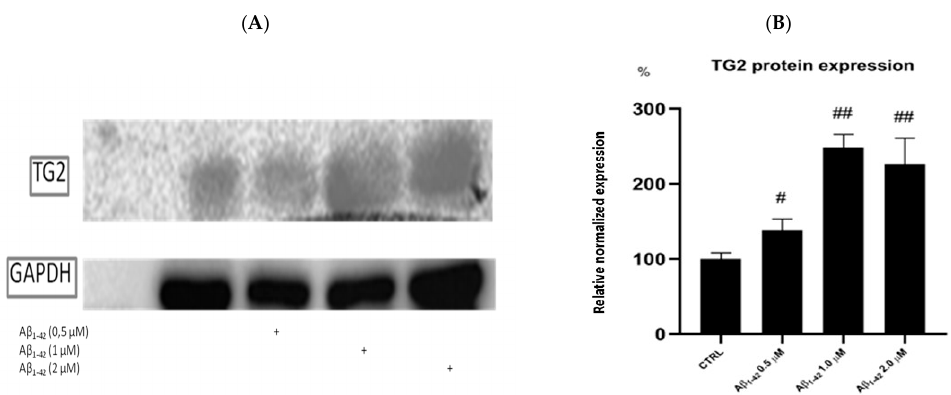
Figure 5. Panel ( A ): Western blot for TG2 expression in BV2 cells after treatment with different concentrations of A β 1-42 for 48 h. SDS-PAGE blotted with antibody against TG2. GAPDH protein expression was used as loading control. The experiments were performed at least 3 different times and the results were always similar; Panel ( B ): graph shows the densitometric intensity of TG2/GAPDH bands ratio. The intensity of signals is expressed as a percentage in respect to the control (CTRL). # p value < 0.05; ## p value < 0.01.